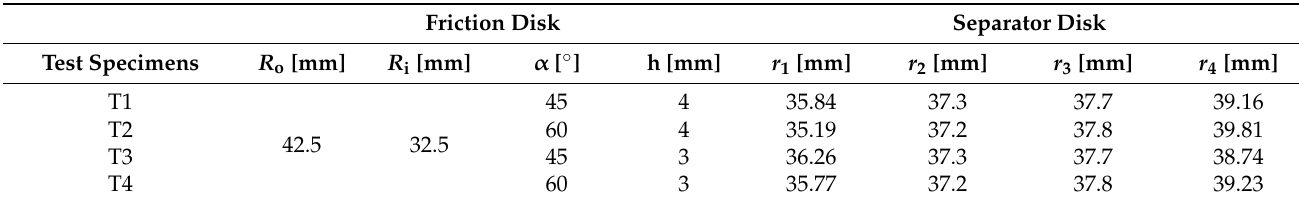
Table 2. Experimental parameters.